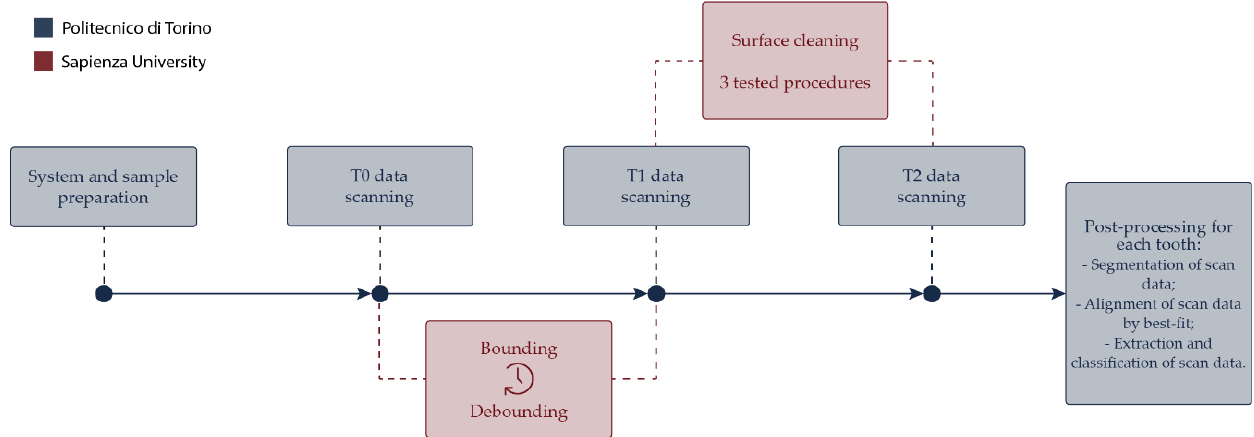
Figure 2. Steps for scan data acquisition.